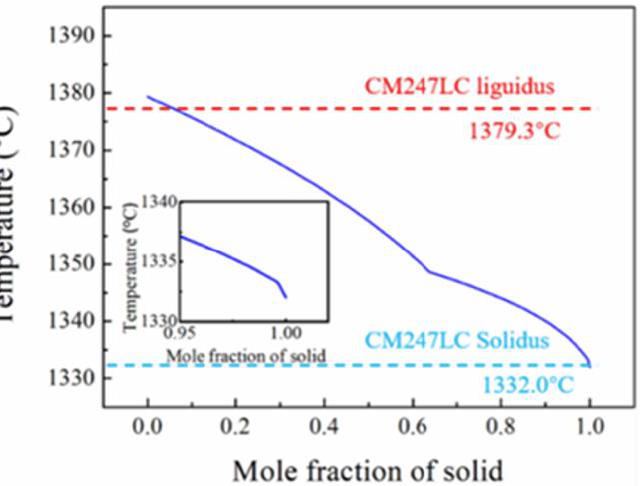
Figure 1. Equilibrium phase fractions between the solidus and liquidus temperatures in experimental alloys: calculated mole fraction of the equilibrium phases for the alloys [15].